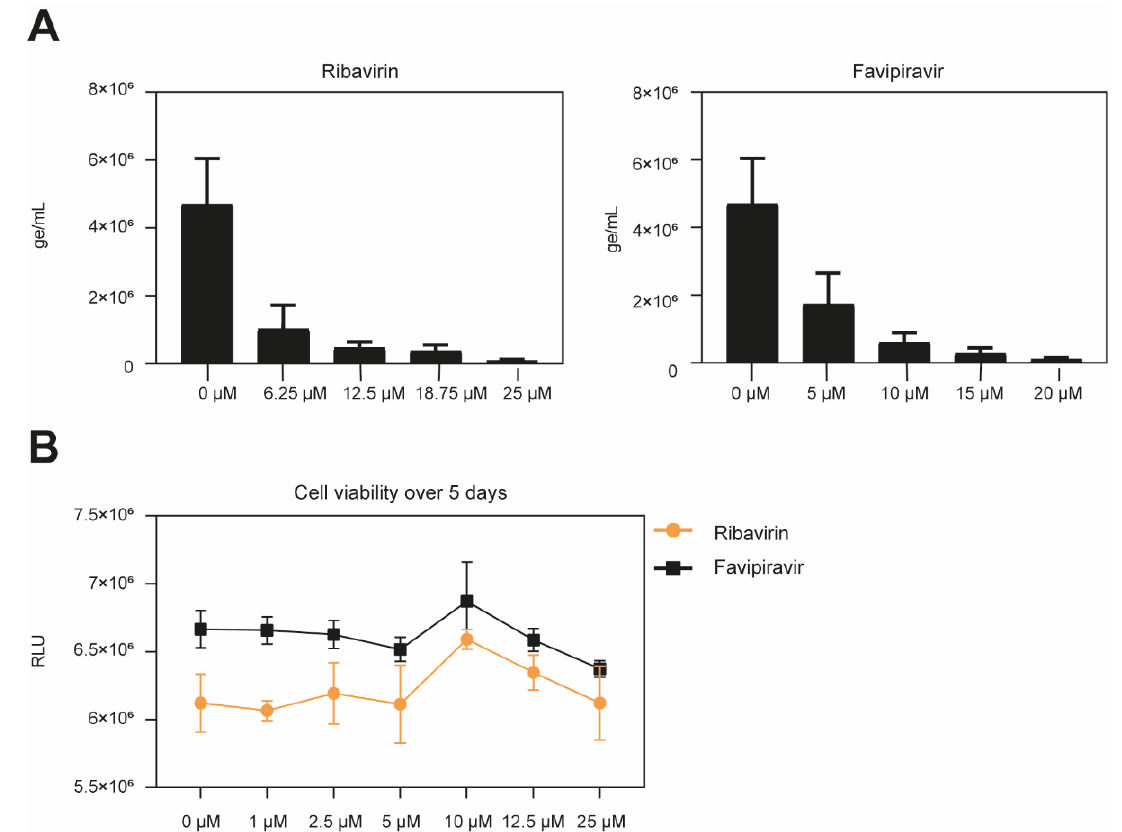
Figure 1. Antiviral activity of ribavirin and favipiravir. ( A ) Dose-response curve in Vero E6 cells treated with ribavirin, or favipiravir. Vero E6 cells were pre-incubated with ribavirin or favipiravir at the indicated concentrations for 1 h at 37 ◦ C, followed by Hantaan virus (HTNV) infection for 1 h at 37 ◦ C. Cells were subsequently washed once with medium